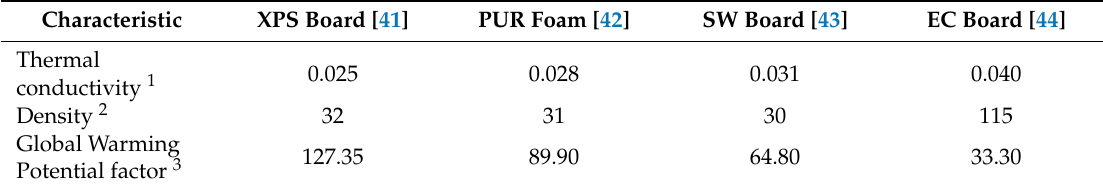
Table 4. Characteristics of the insulation materials.